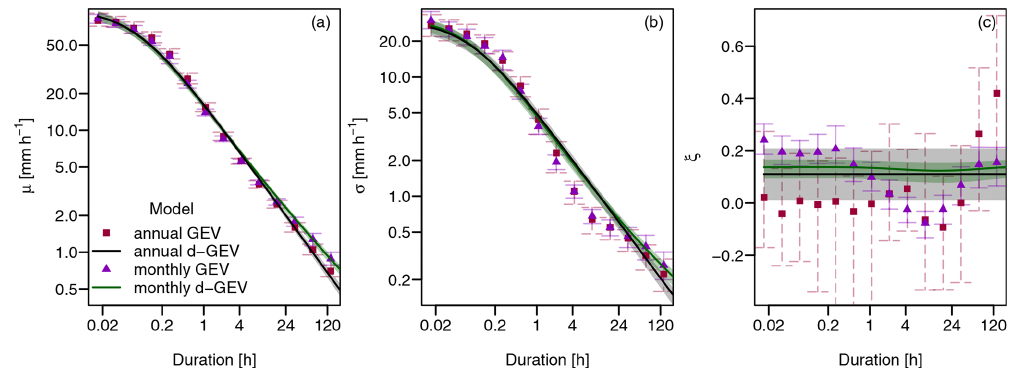
Figure 7. Annual GEV parameters µ , σ , and ξ for station Bever-Talsperre estimated via four different models along with bootstrapped 95% confidence intervals shown as error bars and shaded